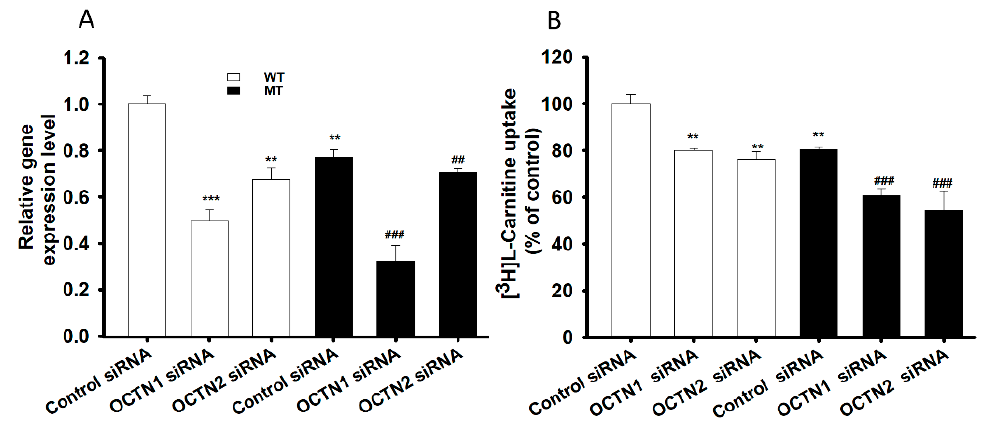
Figure 5. SiRNA transfection study in NSC-34 cell lines. Control, mOCTN1 and mOCTN2 siRNAs, at a concentration of 200 nM, were transfected using Lipofectamine 2000, and cell lines were examined for ( A ) mRNA expression levels using qRT-PCR and ( B ) [ 3 H]L-carnitine uptake for 15 min at pH 7.4. Open space represents WT cell lines and dark space represents MT cell lines in both the figures. Each value represents the mean ± S.E.M ( n = 4) of four independent experiments. *** p < 0.001 and ** p < 0.01 denote significant difference from the WT control, ### p < 0.001 and ## p < 0.01 denote significant difference from the respective MT control.